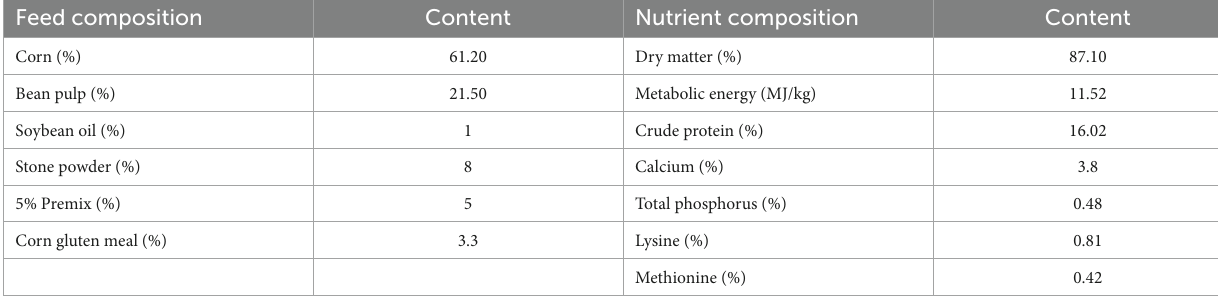
TABLE 3 Nutrient composition and content of basic feed for laying